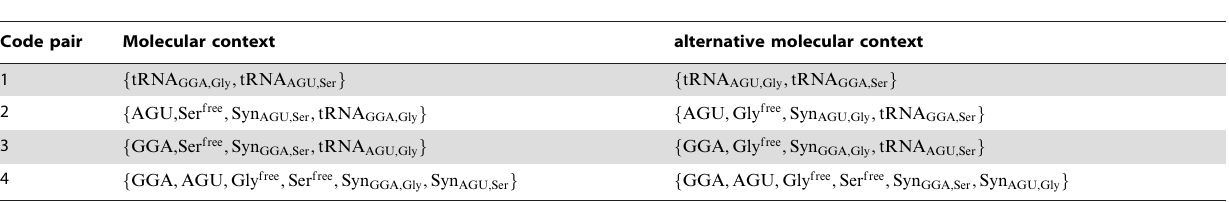
Table 4. Molecular contexts of the codes in the gene translation